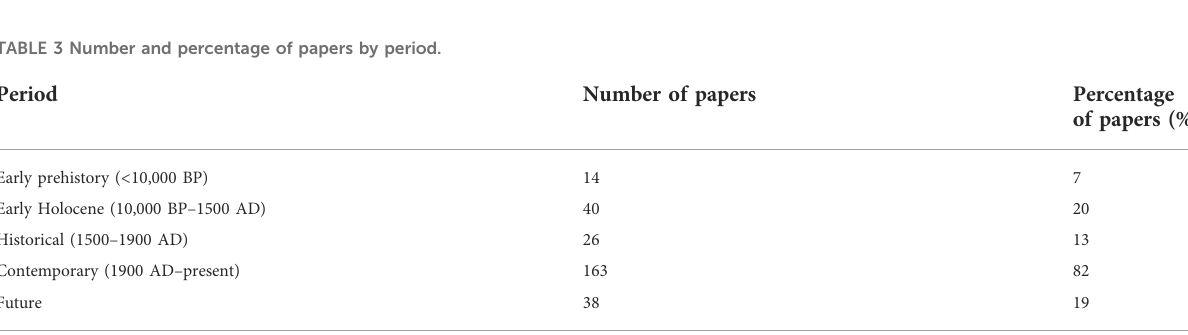
TABLE 3 Number and percentage of papers by